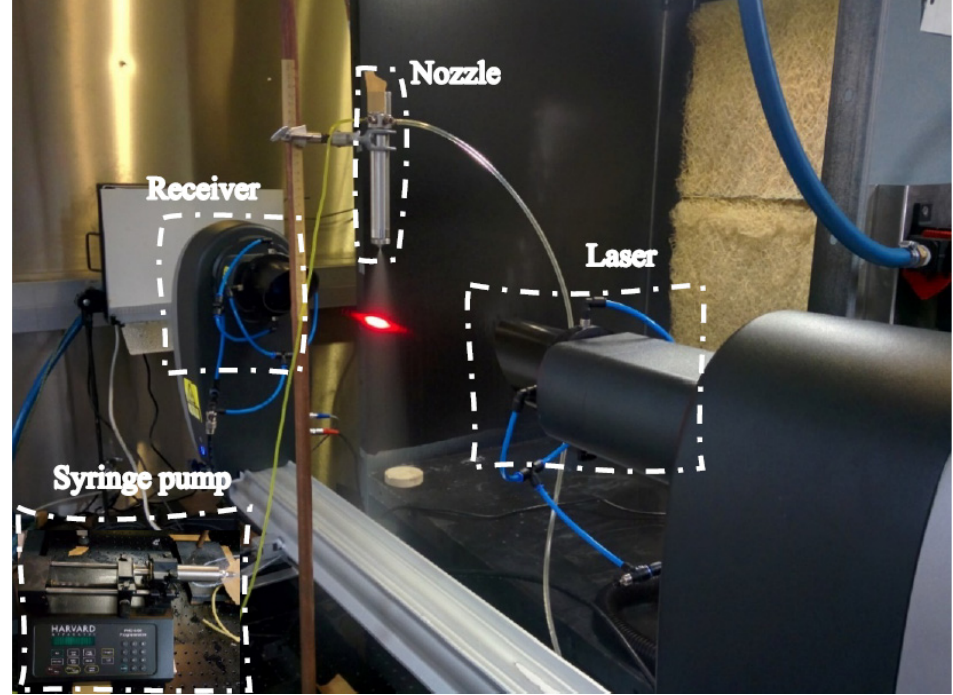
Figure 2. Experimental rig for droplet size